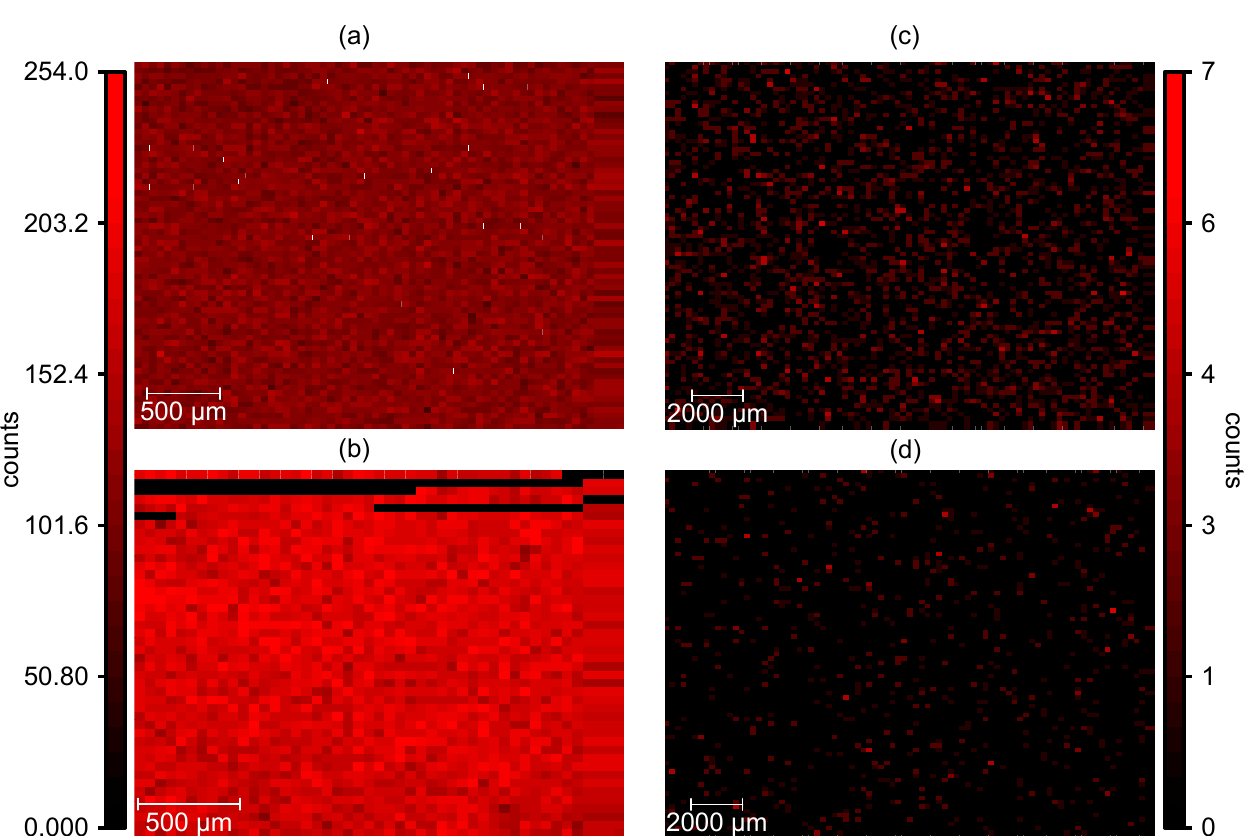
Membranes 2021 , 11 , 576 Figure 4. V(IV) distribution (counts per pixel) in ( a ) Nafion™ and ( b ) PVDF-based membrane before extraction, and in ( c ) Nafion™ and ( d ) PVDF-based membranes after extraction using microXRF.